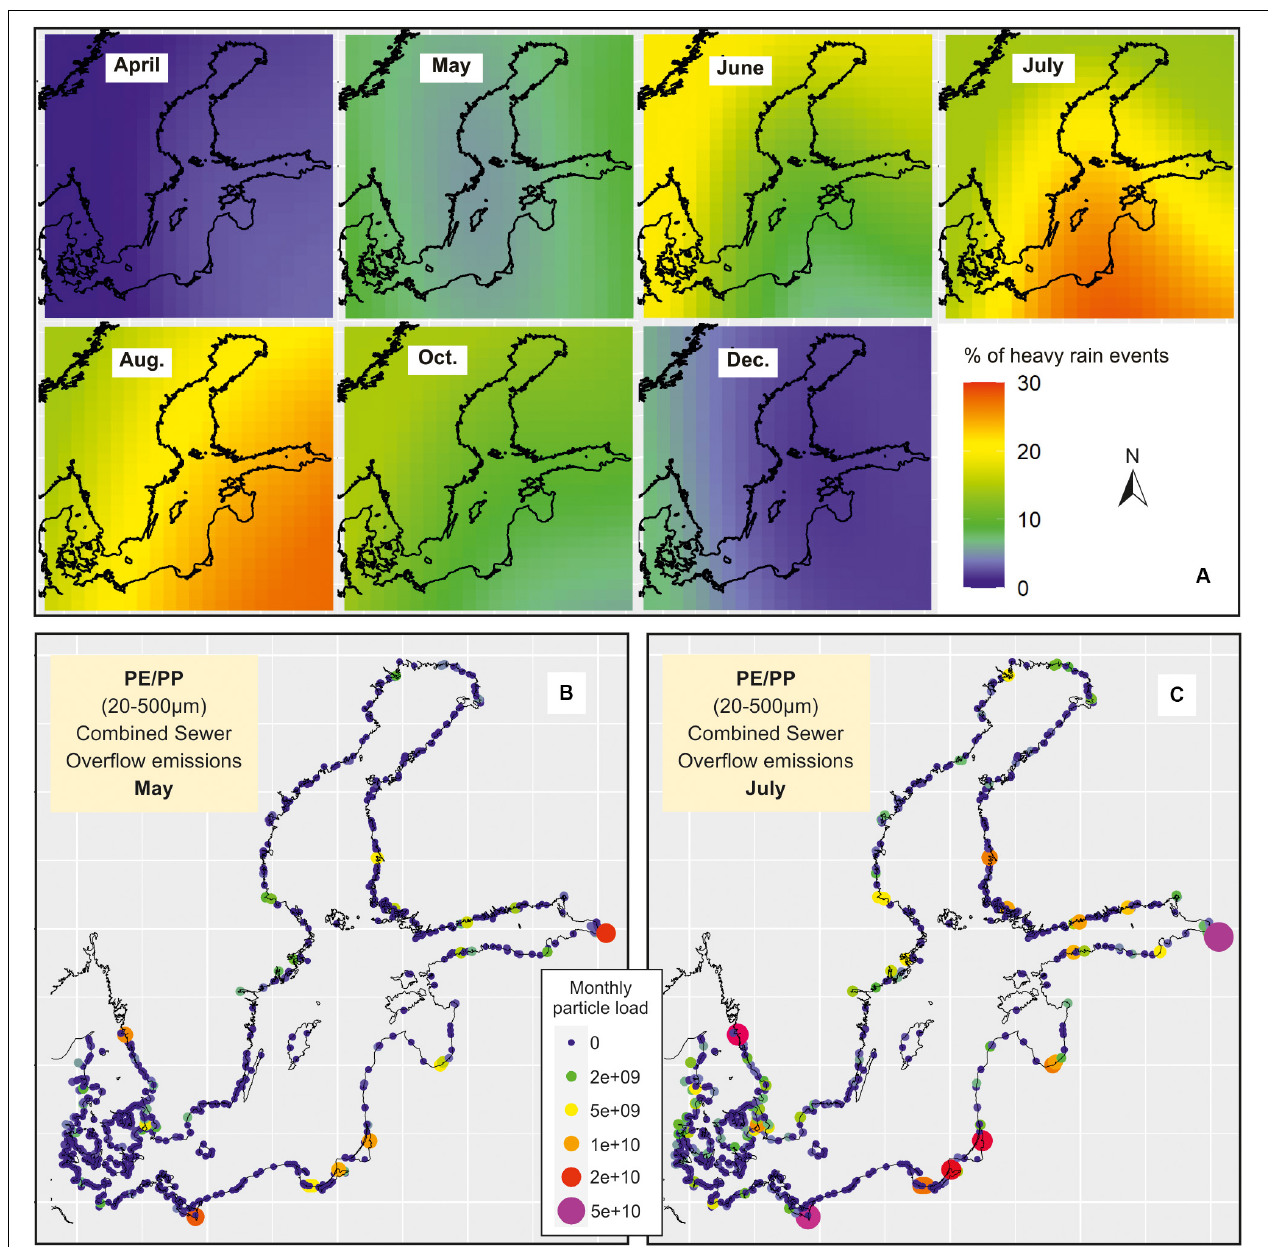
FIGURE 8 | Average monthly spatial distribution of heavy rain events in the Baltic Sea catchment in % of the year (A) . Resulting hypothetical monthly emissions of Polyethylene (PE)/Polypropylene (PP) microplastics particles (20–500 µ m size fraction) to the Baltic Sea, exemplary shown for May (B) and July (C)